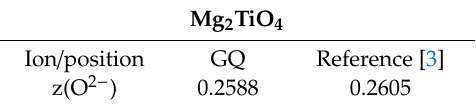
Table 4. The atomic position of Mg 2 TiO 4 (XRD data from Rigaku conventional di ff